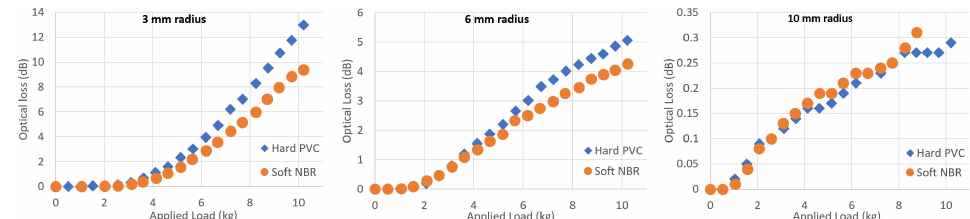
Figure 5. Experimental data comparing hard PVC and soft NBR material forming the macrobend sensor impactors. SSMF was used for all